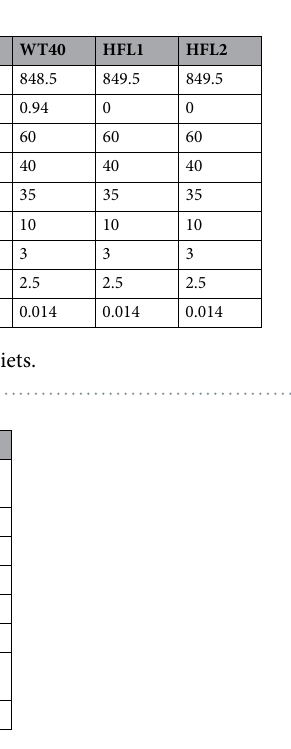
Table 2. Grain composition of HFL and wild type rice (n = 3). * Dry weight basis except for moisture. Different letters represent significant differences from WT ( P < 0.05).